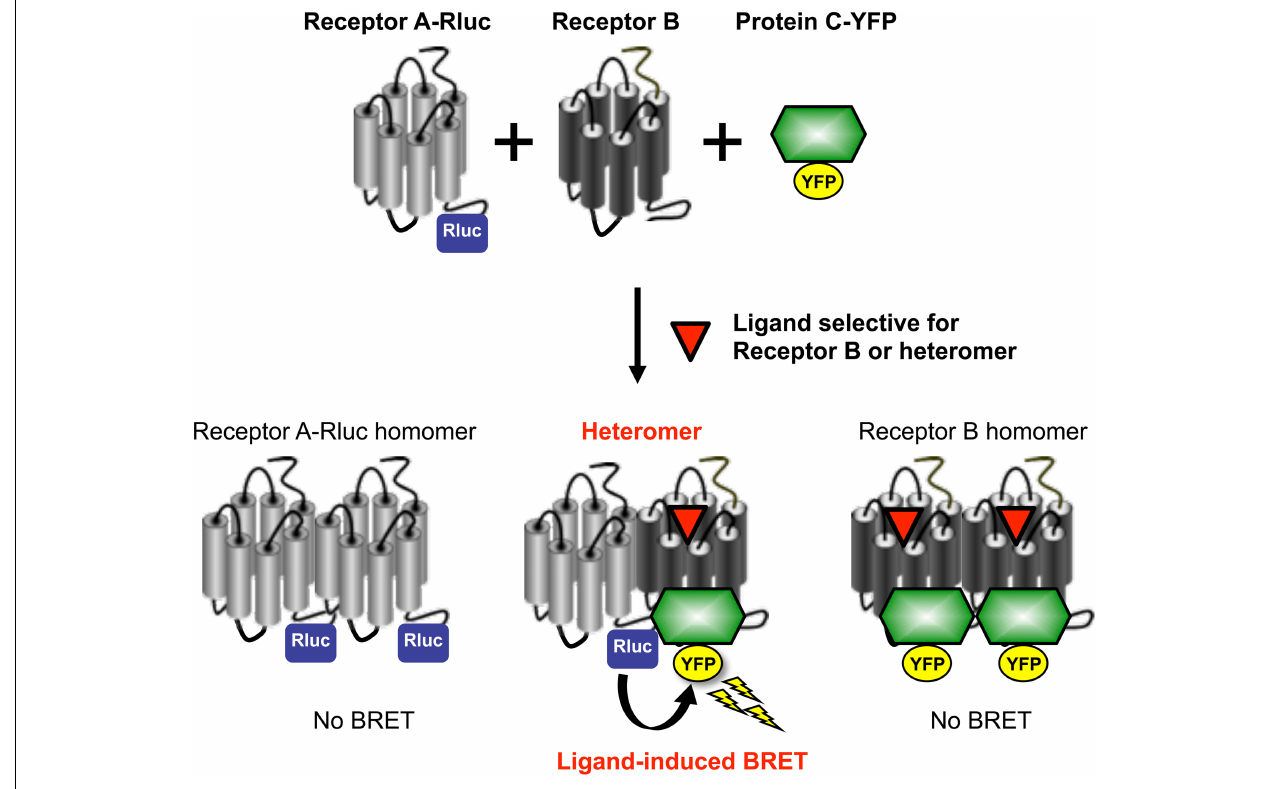
by the donor enzyme will be transferred to the acceptor fluorophore.The resulting BRET signal provides evidence for the two fusion proteins being in the same complex. In contrast to BRET between Rluc andYFP fused to each receptor, a specific receptor heteromer can be monitored by ligand-induced BRET due to proximity of a tagged receptor and a tagged intracellular protein used as a reporter partner (such as β -arrestin or G protein). In this system, energy transfer is measured between Receptor A-Rluc and a Protein C-YFP that interacts with the heteromer complex after selective activation of Receptor B or the heteromer itself. In addition to the induction of BRET by the Receptor B or heteromer-selective ligand providing evidence for Receptor AB heteromerization, it also identifies a biological function of the heteromer. Reprinted from Ayoub and Pfleger (2010). Copyright © 2010, with permission from